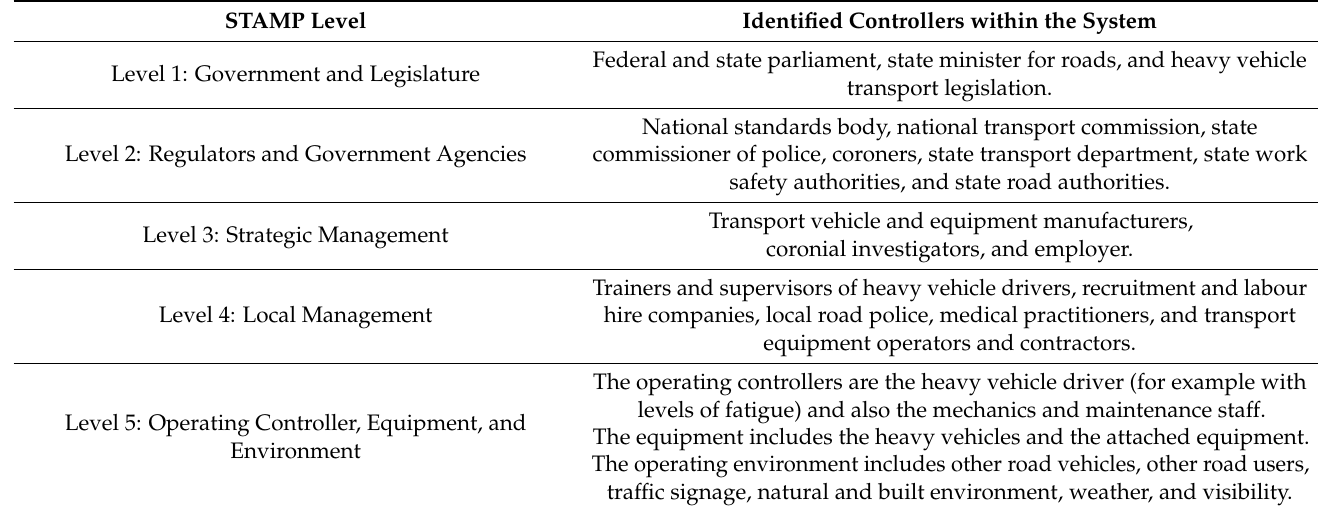
Table 3. Identified Controllers within the Road Freight Transportation System.